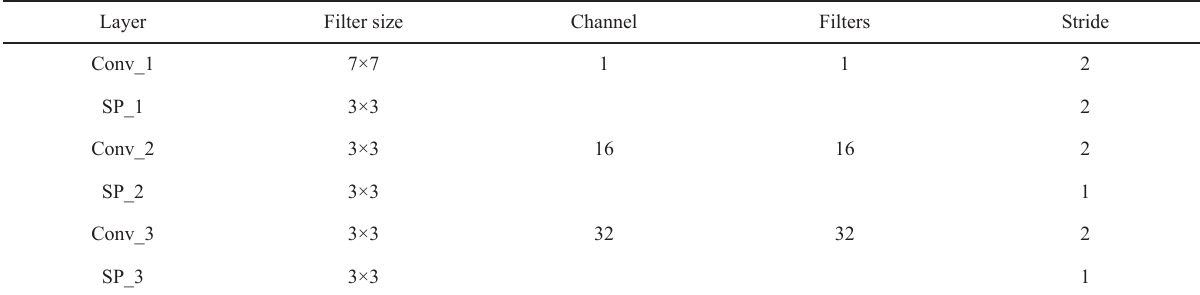
Table 3. Convolutional layers.